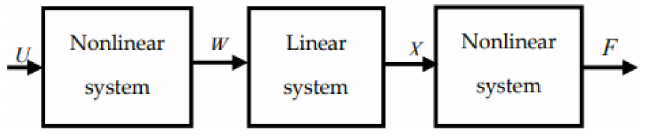
Figure 4. The general structure of the Hammerstein–Weiner